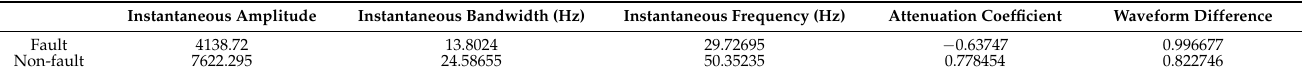
Table 5. The seismic attributes median value of fault samples and non-fault samples. Instantaneous